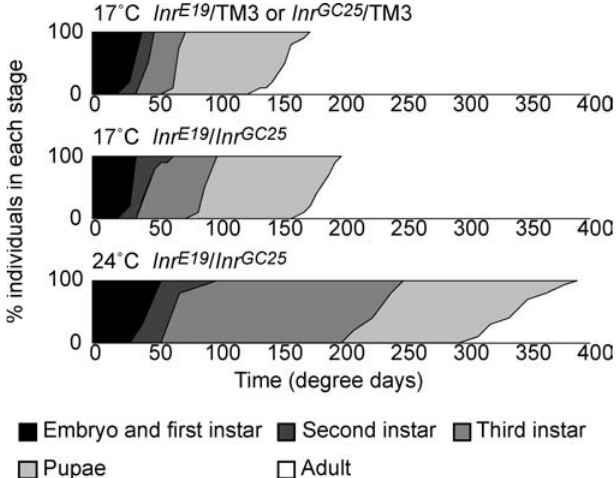
Figure 4. Developmental Delay in 24 8 C Inr E19 /Inr GC25 Flies Occurs primarily through Elongation of the Third Larval Instar Area shows percentage of individuals ( n ¼ 20) in each developmental stage at different times in development. Time is shown in DDs to control for the effect of temperature on developmental rate. DOI: